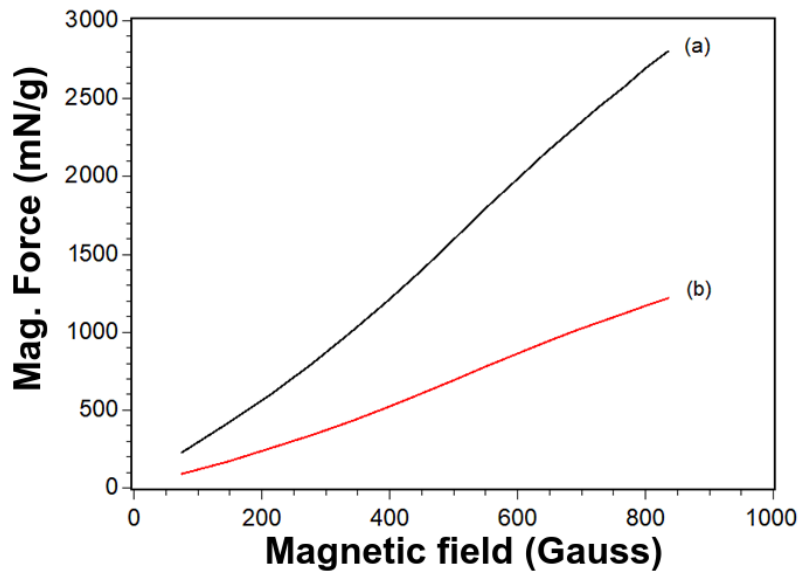
Figure 4. Normalized magnetic force as a function of the magnetic field for magnetite ( a ) and silica-modified ( b ) samples.